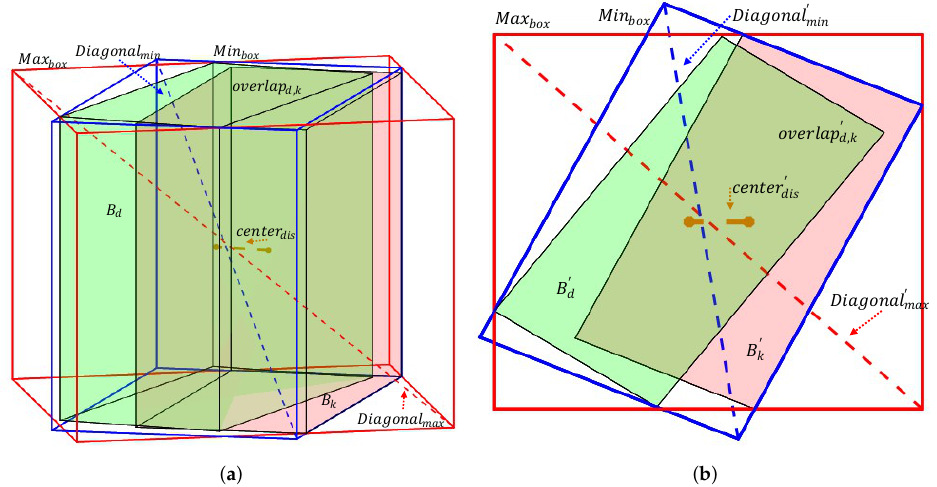
Figure 4. Schematic diagram of the 3D view and top view of 3D-MiIoU. ( a ) 3D-MiIoU. ( b ) Top view of